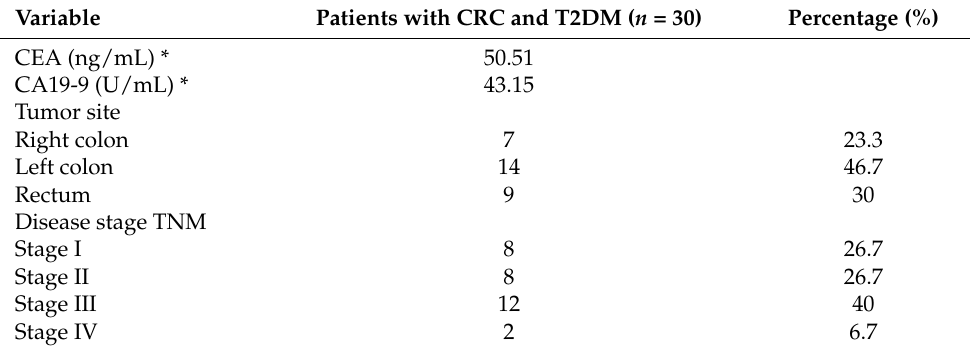
Table 3. Tumor characteristics of patients with CRC and T2DM.